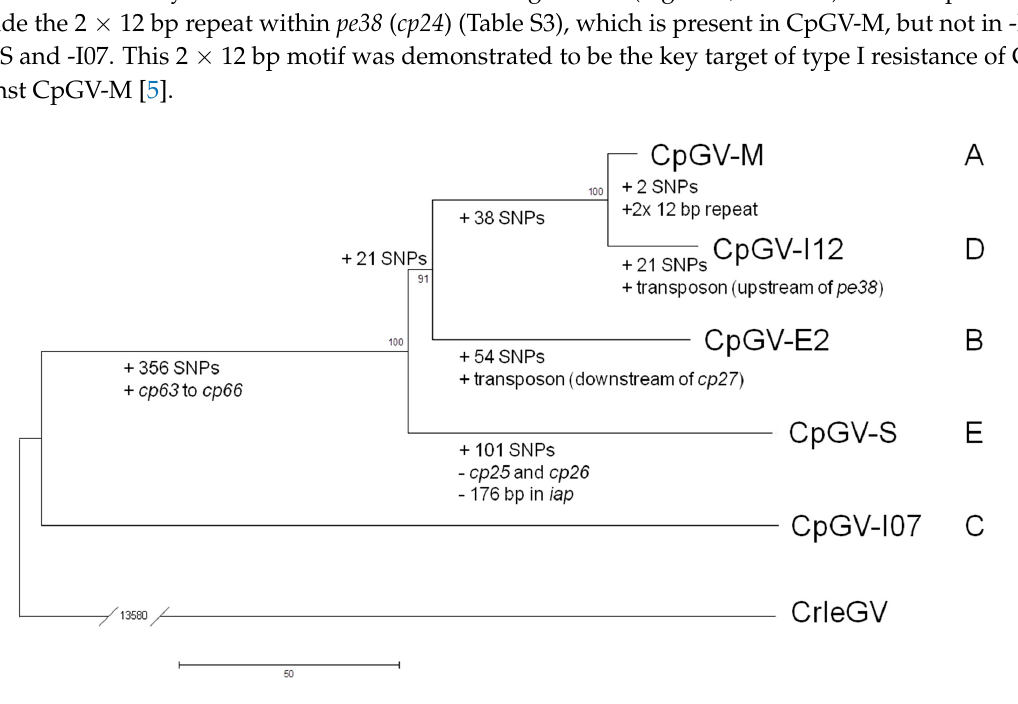
Figure 2. CpGV phylogeny and evolutionary trends of CpGV-M, -I12, -E2, -S and -I07. Phylogeny is based on the minimum evolution method of the alignment of whole genome nucleotide sequences with 1000 bootstrap replicates. CpGV genome groups A to E are given to the right. Cryptophlebia leucotreta granulovirus (CrleGV) was set as outgroup. Group and isolate specific single nucleotide polymorphisms (SNPs) and additional specific genomic features are given below each branch.